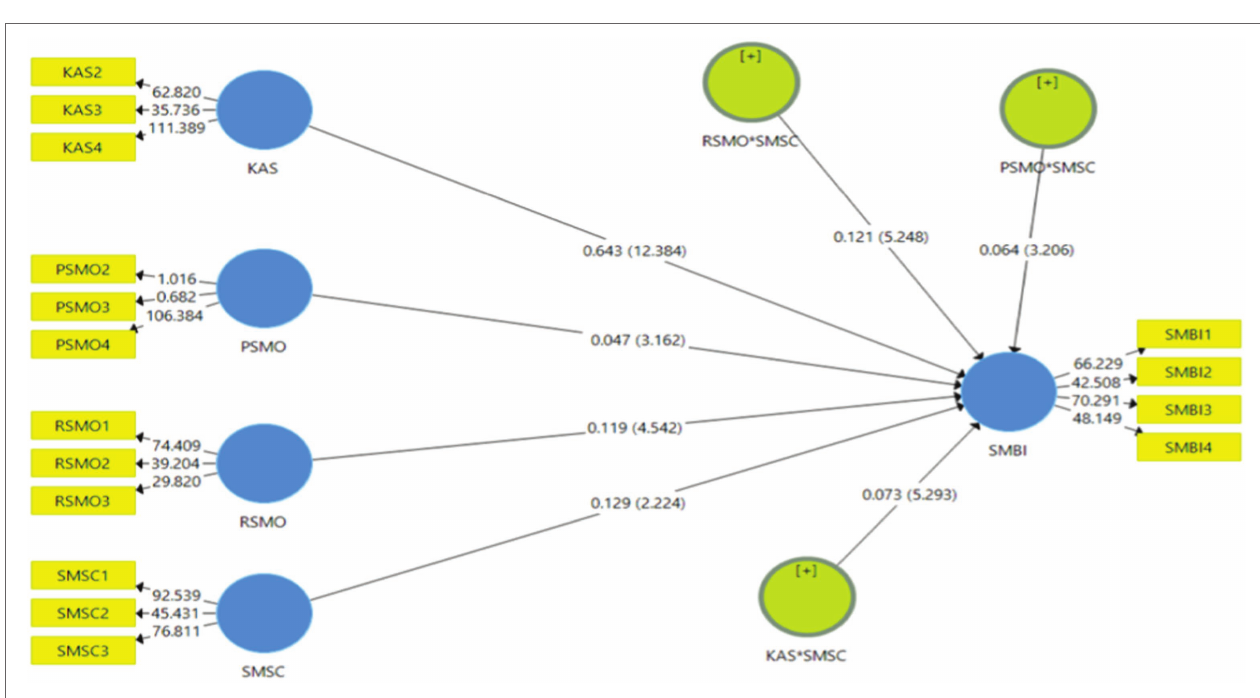
FIGURE 4 | PLS bootstrapping with values of t